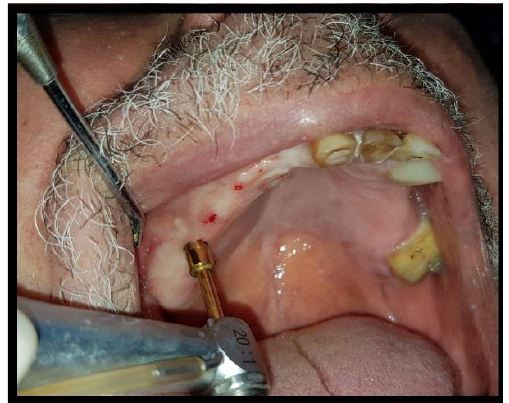
Figure 2: Mucosa was punched by tissue punch.